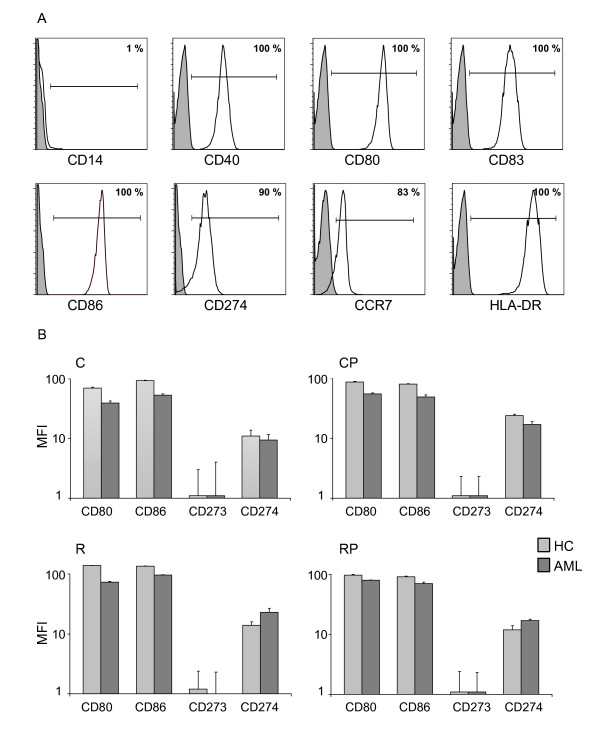
Costimulatory profile of mature DCs generated with a 3-day protocol. (A) Shown is the expression of specific surface molecules detected on DCs by flow cytometry in a representative patient sample generated with cocktail RP. (B) Comparison of the expression intensity of the costimulatory molecules CD80 and CD86 and the coinhibitory molecules CD273 and CD274 between HCs and AML patients. The mean fluorescence (MFI) of at least three individual experiments of HC and AML patients were compared using the different maturation cocktails C, CP, R, and RP.